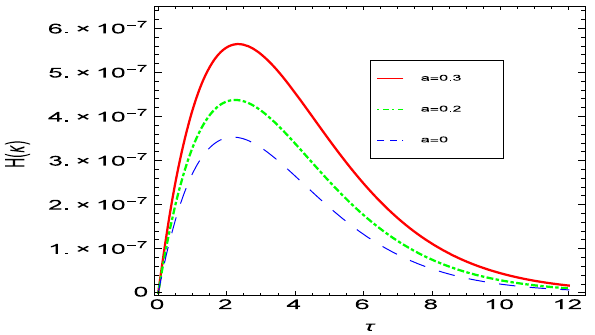
Fig. 6 QFIintheestimationofthedeformationparameterasafunction of the effective time τ with the effective centripetal acceleration a . The initial state parameter is fixed as θ = 0, the effective deformation parameter is given by κ = 1000, and the velocity of detector is v = 0 . 9994. The different effective centripetal acceleration a = 0 , 0 . 2